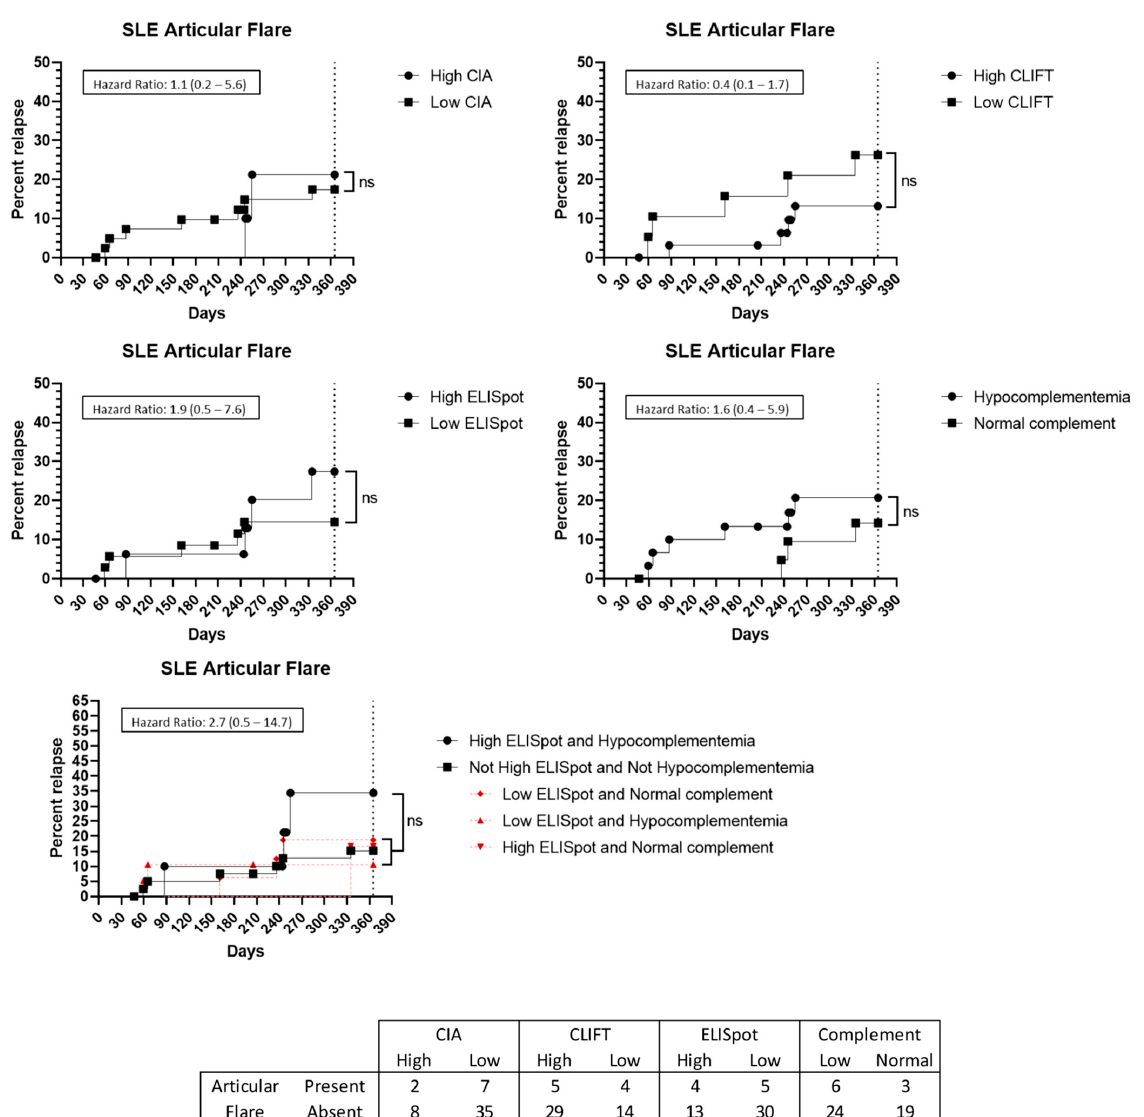
Figure 6. Articular flare up prediction capacity: Kaplan–Meier survival analysis and hazard ratio. X-axis: days from sampling to flare up. Y-axis: percentage of patients presenting with a flare up. ns: non-significant. Abbreviations: CIA: chemiluminescence immunoassay; CLIFT: Crithidia luciliae indirect immunofluorescence test; SLE: systemic lupus erythematosus.